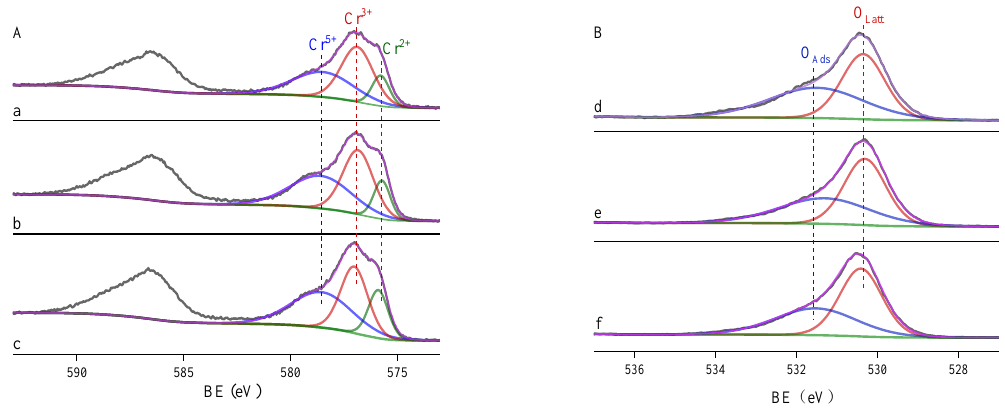
Figure 6. ( A ) Cr 2p (a) 0.4%CqM (b) 0.5%CqM (c) 0.6%CqM; ( B ) O 1s (d) 0.4%CqM (e) 0.5%CqM (f) 0.6%CqM. Table 2. The binding energies of core electrons of xCqM and the percent of differential valence state.